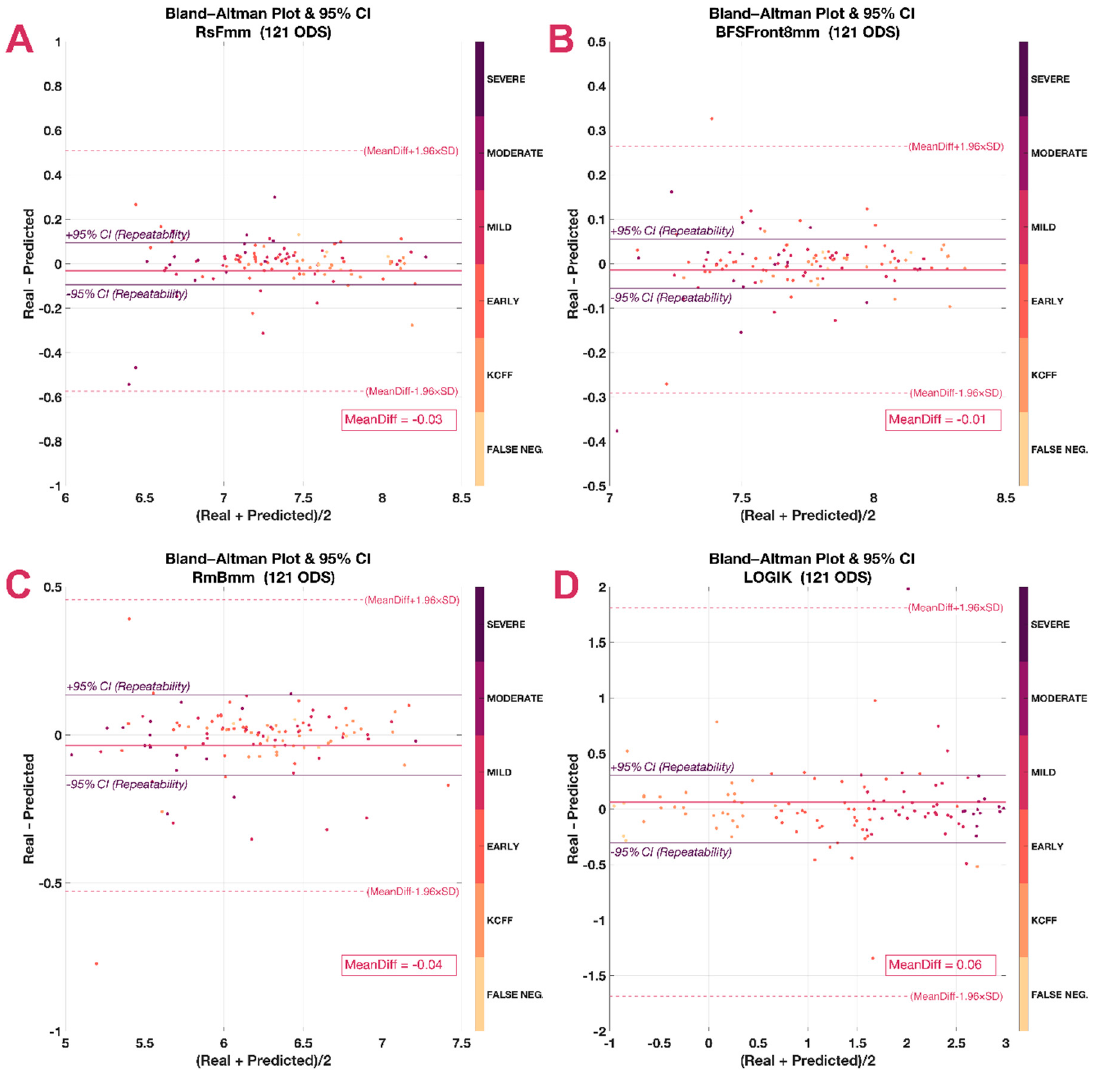
Figure 4. Bland–Altman plots. Besides the mean difference (MeanDiff) and its confidence intervals (dashed line), they include the repeatability (continuous line and italics). ( A ) Steepest radius of the front surface in mm (RsF), ( B ) average radius of the back surface in mm (RmB), ( C ) best fit sphere of the front surface considering an 8 mm area (BFSF), ( D ) logistic index for keratoconus, LOGIK.